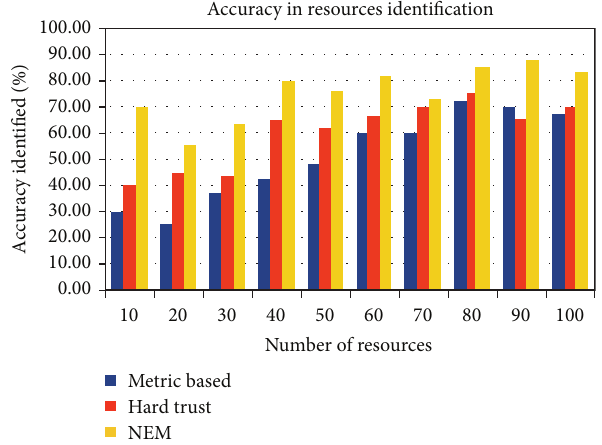
Figure 8: Trusted resources accuracy in percentage (%).